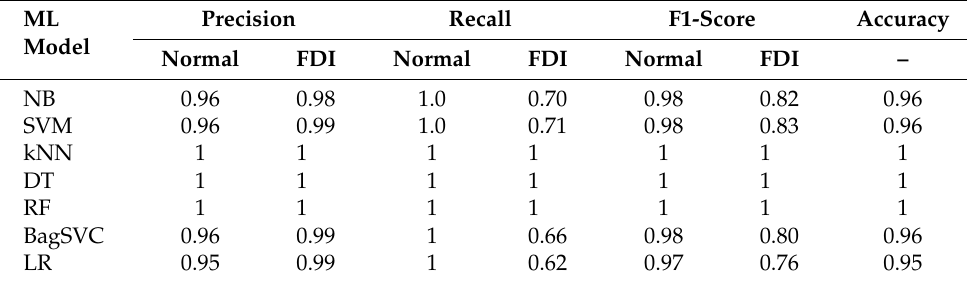
Table 6. Classifiers’ performance in the water treatment dataset.